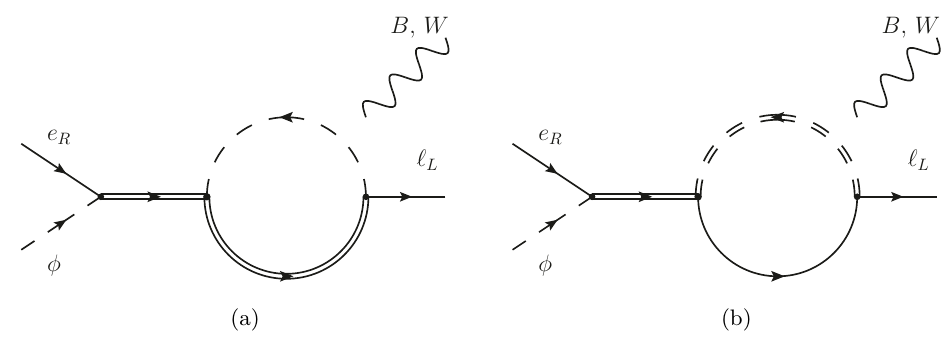
Figure 1 . Left: bridge topology for the fermionic bridge with an extra heavy fermion and the SM Higgs. Right: bridge topology for the fermionic bridge with an extra heavy scalar and a SM fermion. Double lines represent heavy particles whereas single lines are SM particles. The gauge boson ( B or W ) is represented outside the diagram since it can be attached to any of the internal propagators.